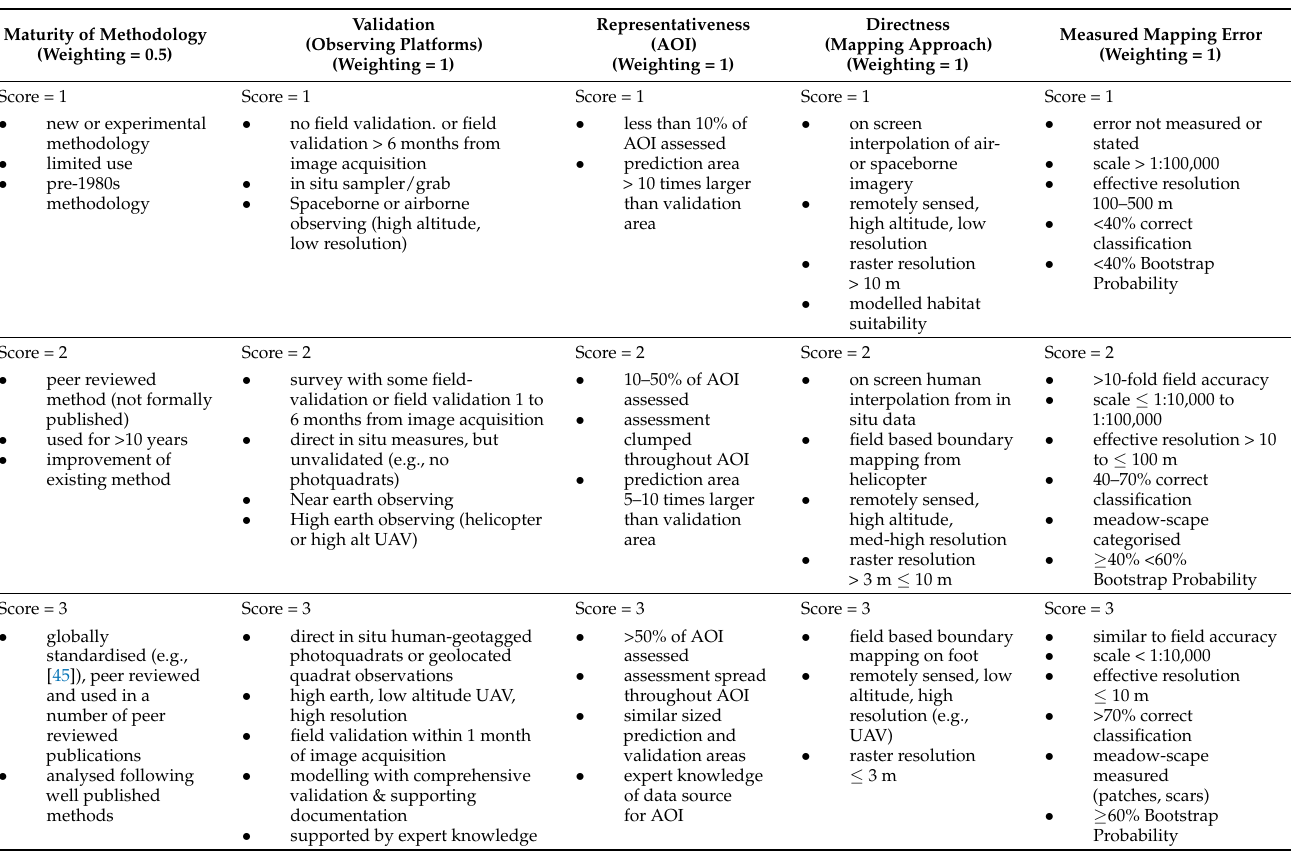
Table 4. Mapping confidence scoring matrix. Confidence scoring and categories used: very low, ≤ 5; low, >5 ≤ 7.5; moderate, >7.5 ≤ 10; high, >10 ≤ 12; very high, >12. Criteria are weighted relative to their perceived level of importance for the assessment being addressed. Modified [37]. Scales and effective resolution adapted from [40–42], ancillary attributes from